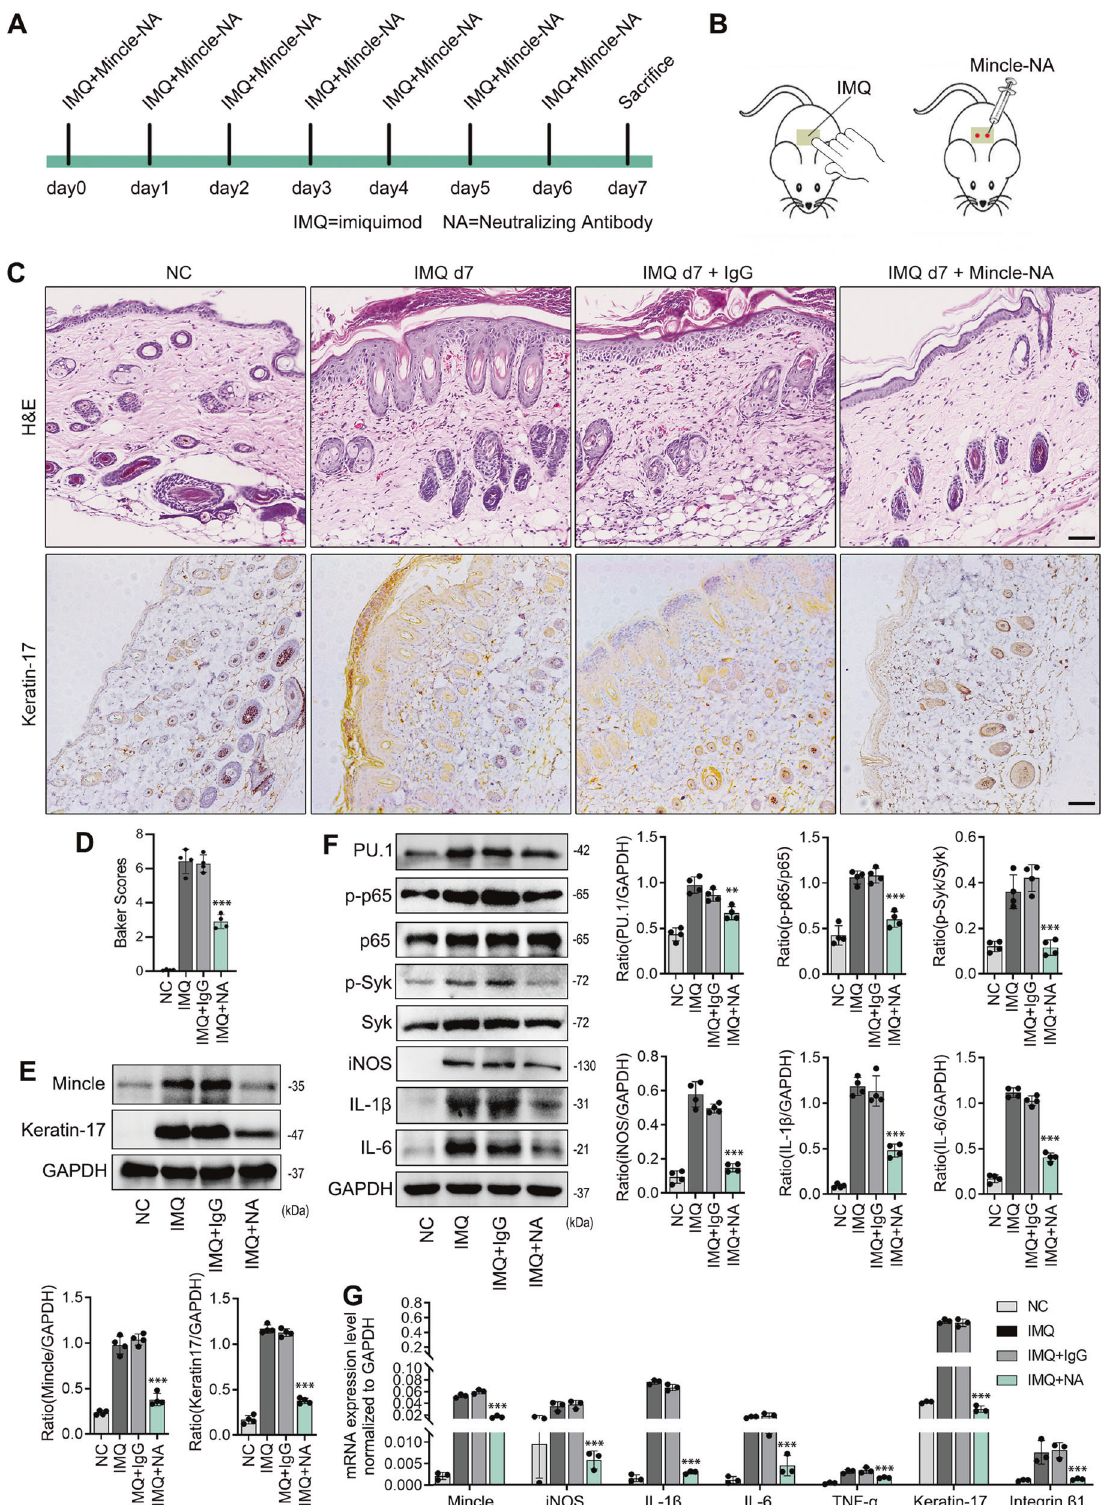
Fig. 7 Targeting Mincle improves the skin lesion in psoriasis mouse model. A Timeline of subcutaneous injection of Mincle neutralizing antibody in psoriasis mice. B Schematic diagram of administration of Mincle neutralizing antibody to mice. C H&E and immunohistochemistry staining showed the histopathology and expression of keratin-17 of skin in Ctrl and Mincle neutralizing antibody-treated psoriasis mice. D Baker score of H&E staining. E Western blot detected the protein levels of Mincle and keratin-17 in each group. F Western blot results showed the level of in fl ammation-related proteins including PU.1, p-p65, p65, p-Syk, Syk, iNOS, IL-1 β and IL-6 in each group. G Real-time PCR analyzed the mRNA expression of Mincle, iNOS, IL-1 β , IL-6, TNF- α , keratin-17 and intergrin β 1 in each group. n = 4 in each group. ** P < 0.01, *** P < 0.001 vs. IMQ